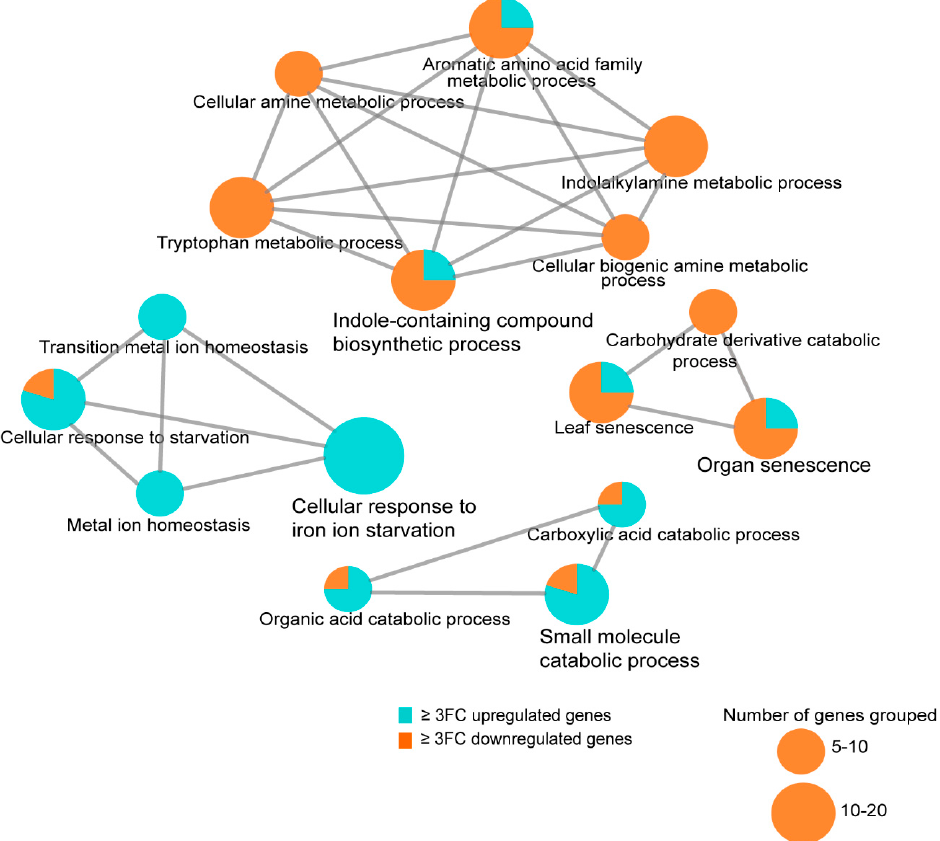
Figure 8. Transcriptome analysis of the Arabidopsis transgenic line expressing Mlp124357.